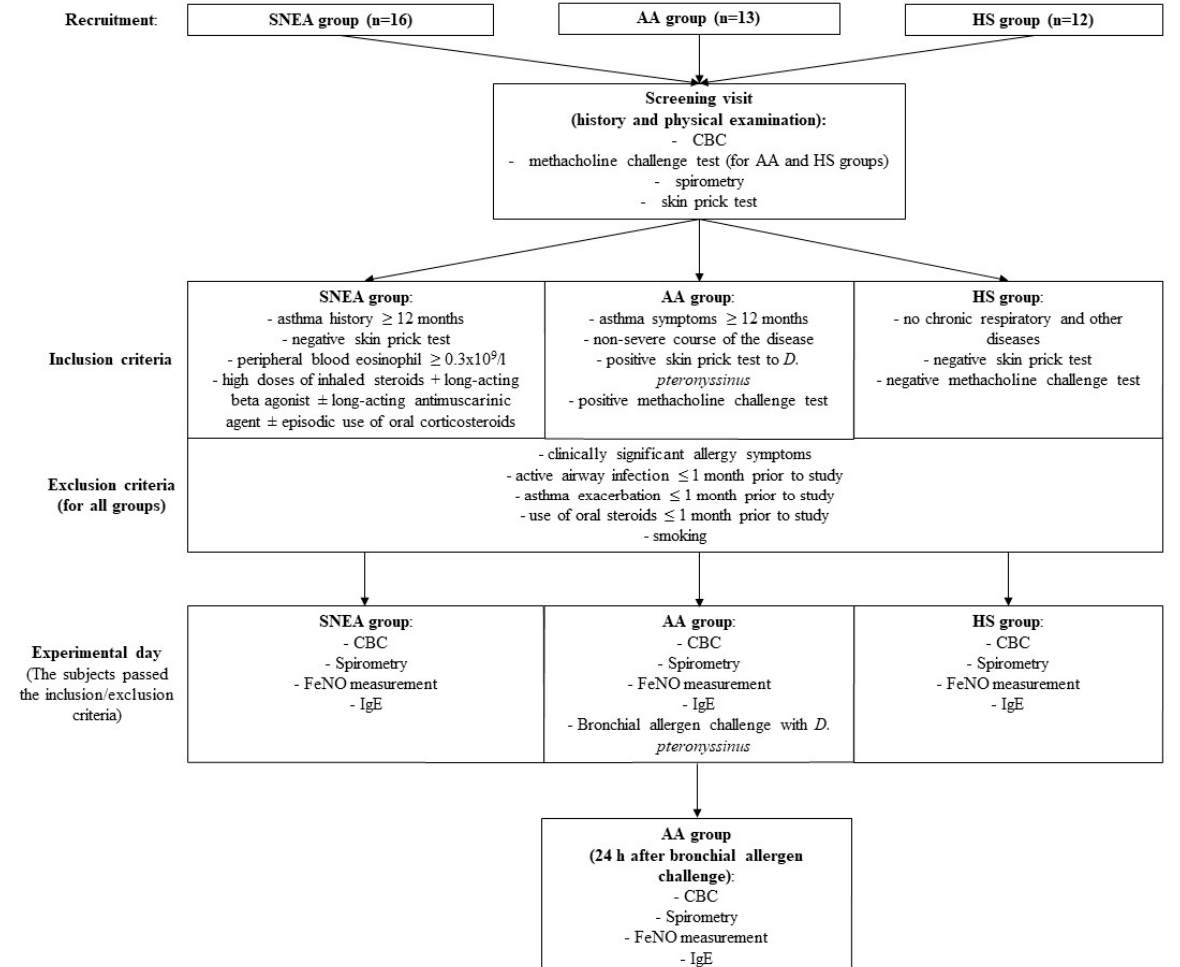
Figure 1. Study design and inclusion and exclusion criteria. AA, allergic asthma; CBC, complete blood count; FeNO, fractional exhaled nitric oxide; HS, healthy subjects; SNEA, severe non-allergic eosinophilic asthma.